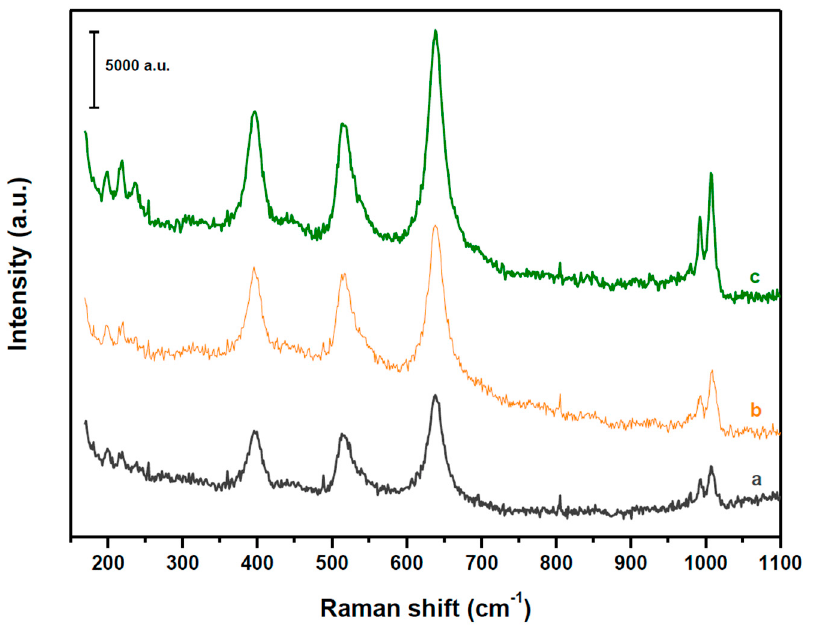
Figure 4. Raman spectra of HPW/Ti acid catalysts: 1.4HPW/Ti (a), 1.7HPW/Ti (b) and 2.7HPW/Ti (c).